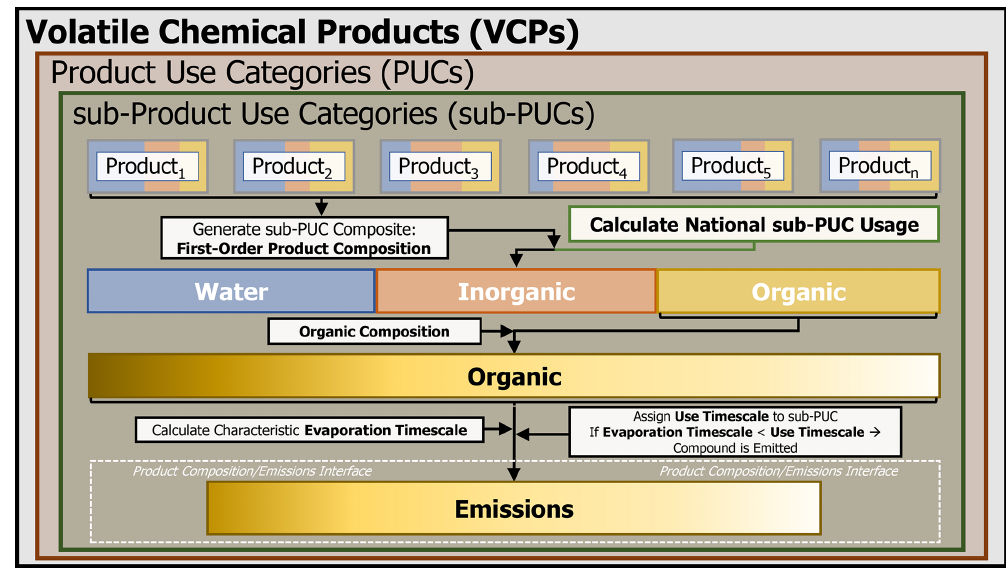
Figure 1. Conceptual overview of the VCPy framework. Note that PUC stands for product use